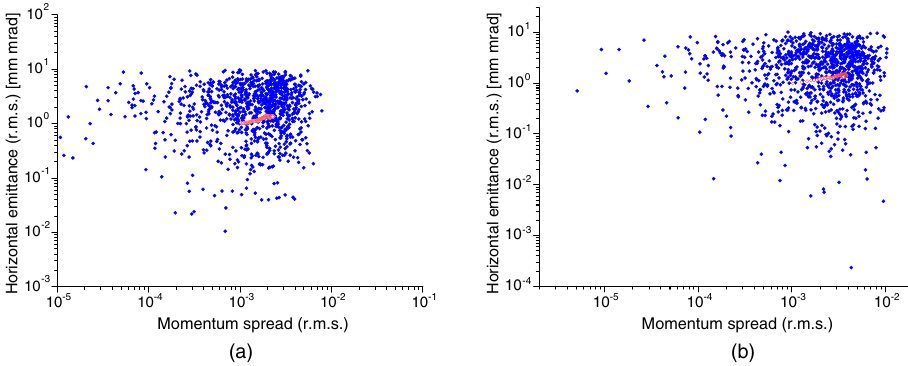
FIG. 8. Distribution of a 22 keV O (cid:3) ion beam in 3D phase space ( (cid:1) p=p , " x ). Scattered points (blue) are particle invariants simulated in the frame of the model beam algorithm. Evolution of rms emittance and momentum spread in time is outlined by red circled points: (a) low-intensity beam ( N o ¼ 10 6 ions), the beam distribution in energy is of Gaussian shape; (b) high-intensity beam ( N o ¼ 1 : 6 (cid:6) 10 7 ions), the ions with high momentum spread are cut off by longitudinal ring acceptance.